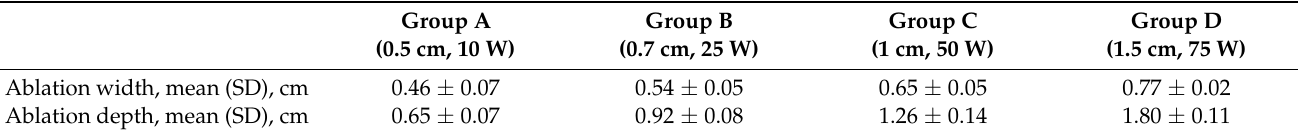
Table 1. Ablation effects based on the length of the exposed distal end of the RFA electrode and RFA power. Table 2. Ablation effects based on the RFA power and ablation time.